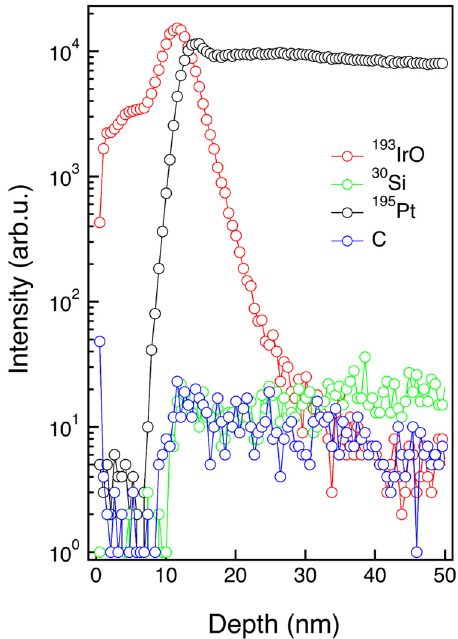
Figure 5. ToF-SIMS depth profiles of the IrO 2 film deposited on PtSi. 193 IrO − secondary ion signal indicates the presence of a homogeneous IrO 2 film with negligible carbon contamination. 195 Pt − and 30 Si − signals are reported as markers of the PtSi substrate.